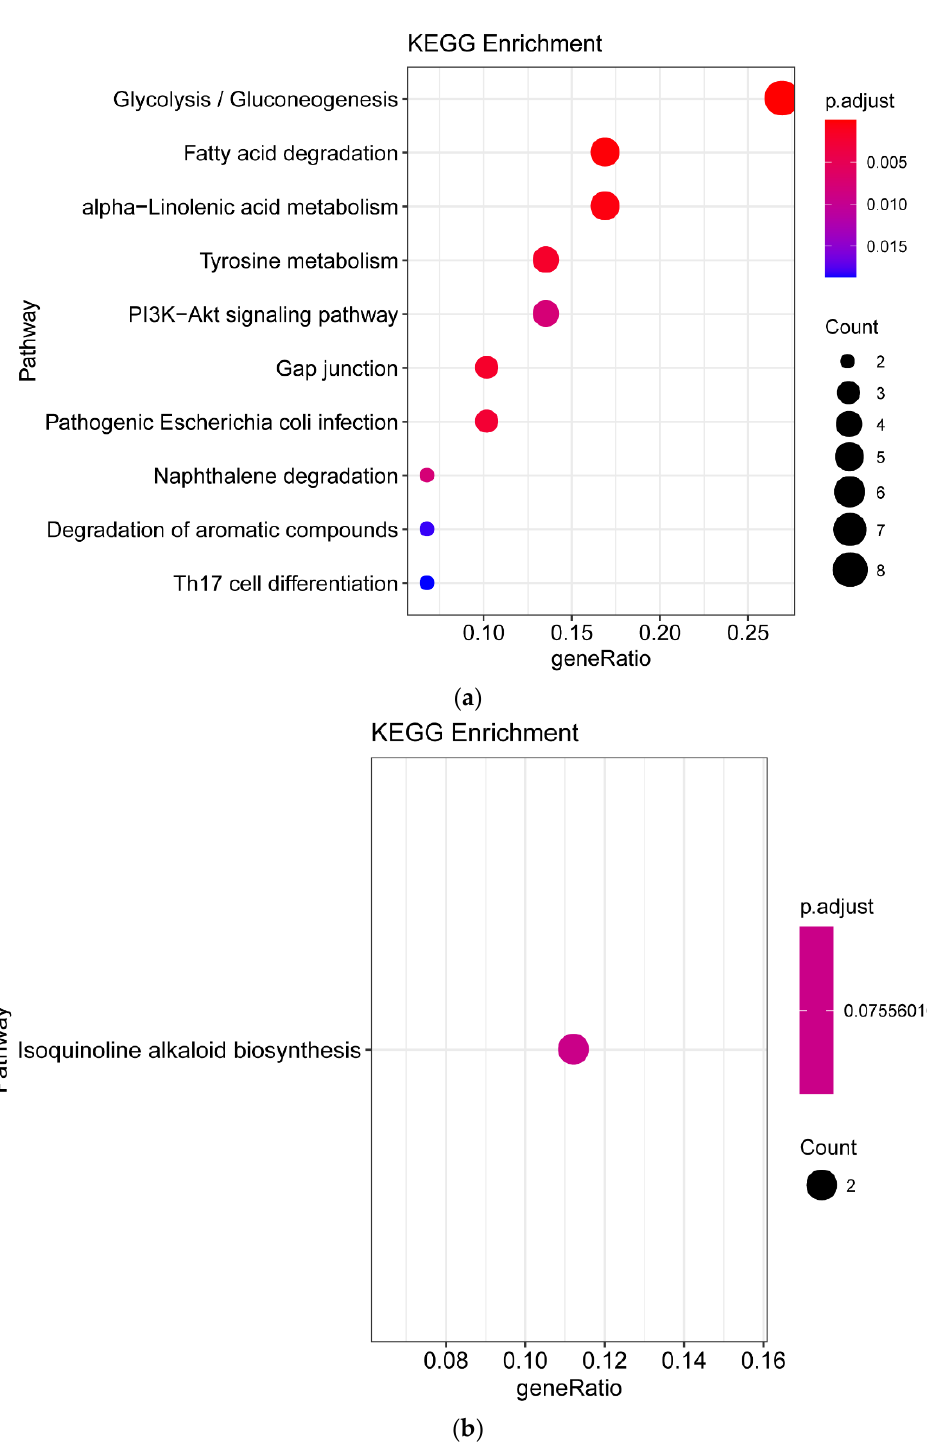
Figure 7. KEGG enrichment of DEGs in the root of WH3 vs. BH. ( a ) upregulated genes; ( b ) downregulated genes.